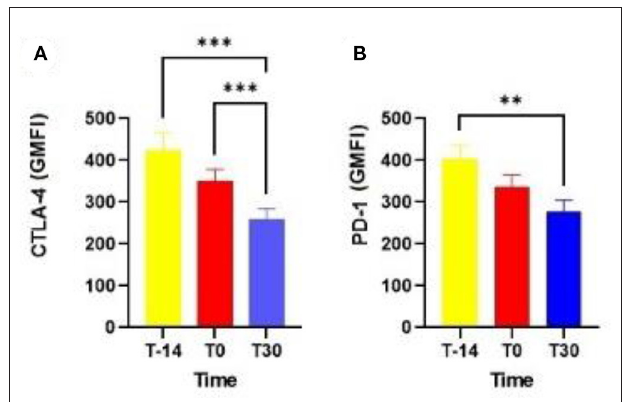
FIGURE 1 | Expression of CTLA-4 (A) and PD-1 by blood T lymphocytes in dairy cows at T-14, T0, and T30 (B) . CTLA-4: cytotoxic T lymphocyte-associated antigen-4; PD-1, programmed cell death protein 1; T-14 = 14 days before delivery; T0 = day of delivery; T30 = 30 days postpartum; GMFI, geometric mean fluorescence intensity. ** P < 0.01; *** P < 0.0001.